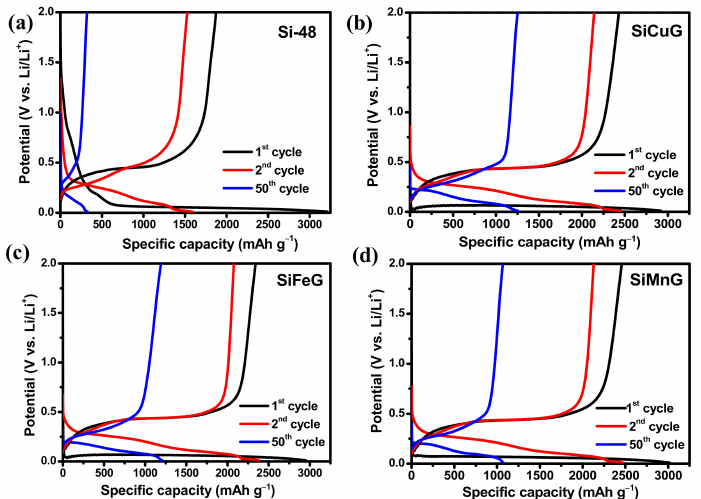
Figure 9. Voltage vs. specific capacity profiles for 1st, 2nd, and 50th cycles of ( a ) Si-48, ( b ) SiCuG, ( c ) SiFeG, and ( d ) SiMnG vs. Li/Li + as counter electrode with 1 M LiPF 6 in EC:DEC:FEC ( v / v ratio of 5:70:25), at 200 mA g − 1 in the potential window of 0.01–2.0